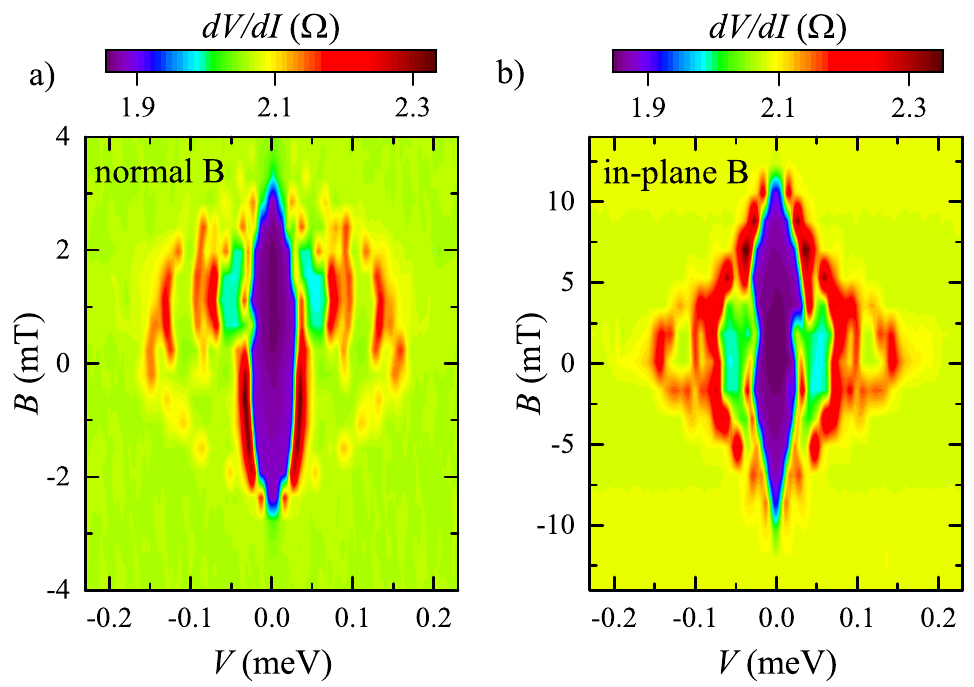
Figure 3. (Color online) Suppression of dV / dI ( V ) non-Ohmic behavior by magnetic field at 30 mK temperature for normal ( a ) and in-plane ( b ) field orientations. The behavior is qualitatively similar, while the critical fields B c differ significantly for these two orientations. There is also some asymmetry of the colormap for normal field orientation ( a ), which is verified to be independent on the magnetic field sweep